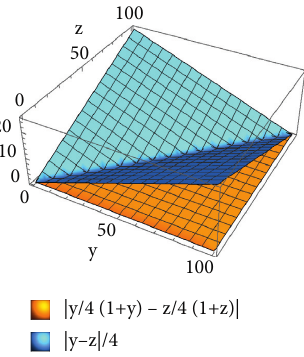
Figure 2: Inequality in